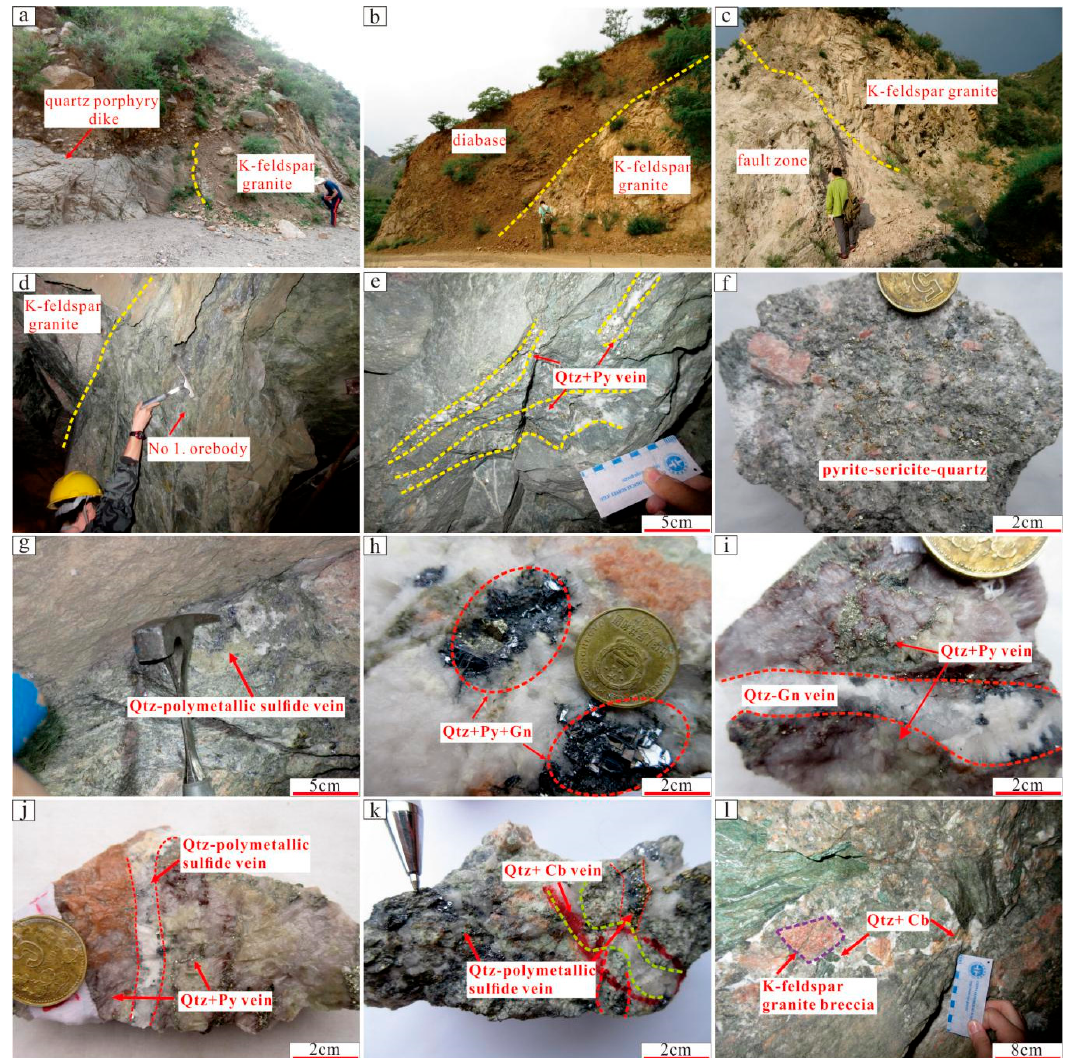
Figure 4. Representative photographs of field features and hand specimens. ( a ) The quartz porphyry intruded into the K-feldspar granite; ( b ) the contact zone between diabase and K-feldspar granite; ( c ) the contact zone between fault zone and K-feldspar granite; ( d ) the number 1 orebody at level 194 m; ( e ) Quartz–pyrite vein in an early-stage gneiss; ( f ) early-stage pyrite–sericite–quartz altered rocks; ( g ) middle-stage quartz–polymetallic sulfide vein in gneiss; ( h ) middle-stage quartz, pyrite, and galena in altered K-feldspar granite; ( i ) early-stage quartz–pyrite vein cut by middle-stage quartz–galena vein; ( j ) early-stage quartz–pyrite vein cut by middle-stage quartz–polymetallic sulfide vein; ( k ) middle-stage quartz–polymetallic sulfide vein cut by late-stage quartz–carbonate vein; ( l ) and hydrothermal breccia and late-stage quartz–carbonate vein. Mineral abbreviations: Py, pyrite; Gn, galena; Qtz, quartz; and Cb, carbonate.